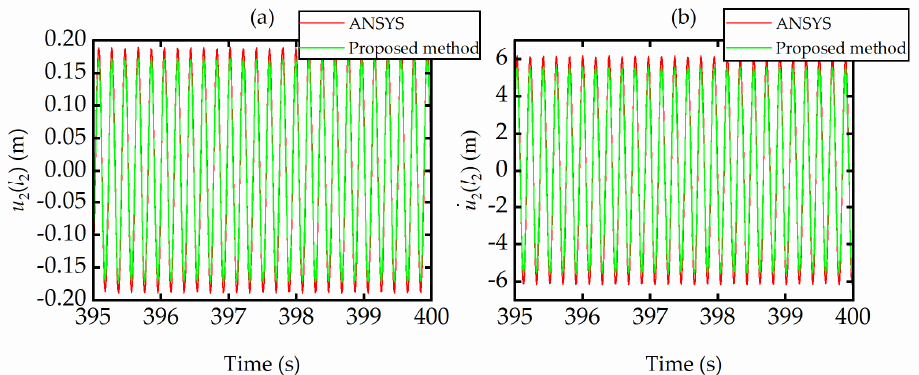
Figure 6. The steady − state response time histories of Beam − 2 end point: ( a ) displacement; ( b ) velocity.